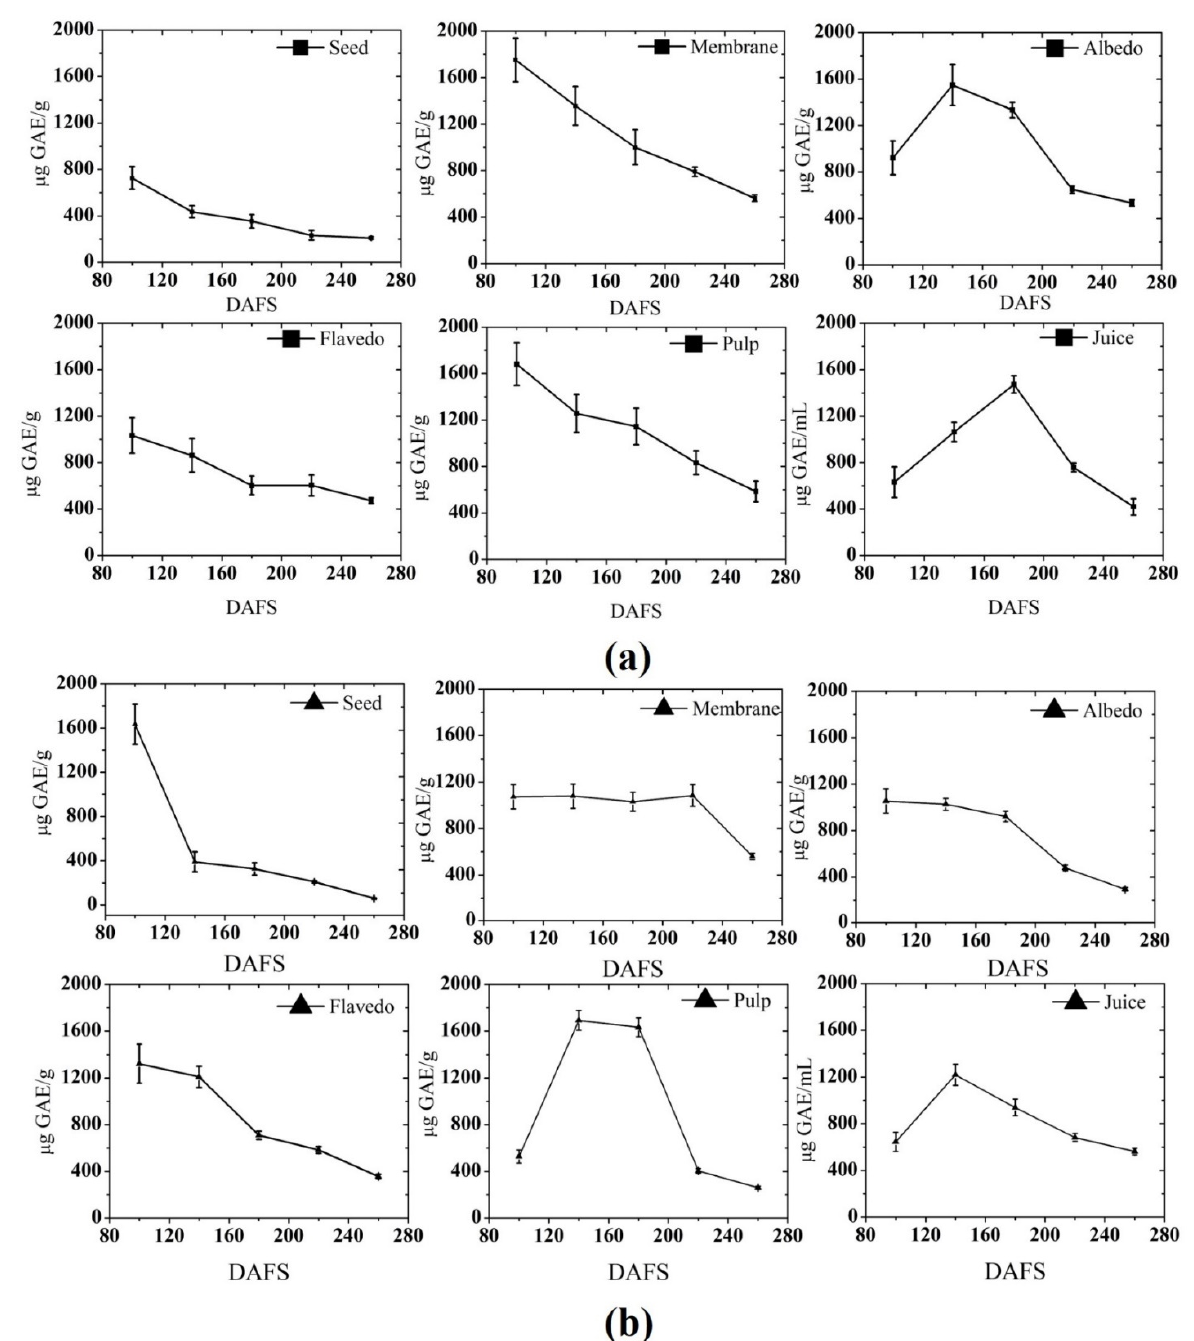
Figure 2. Total phenolic content in ( a ) 2018; and ( b ) 2019. DAFS; days after fruit set.